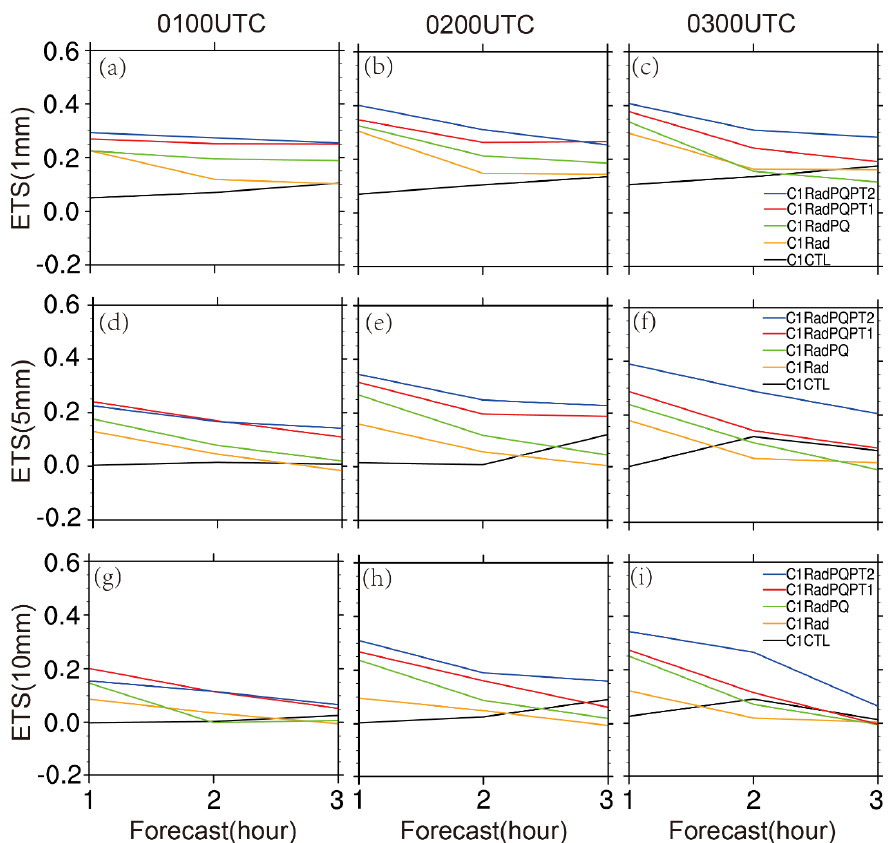
Figure 9. Equitable Threat Score (ETS) for the 3-h forecasts calculated from 1-h